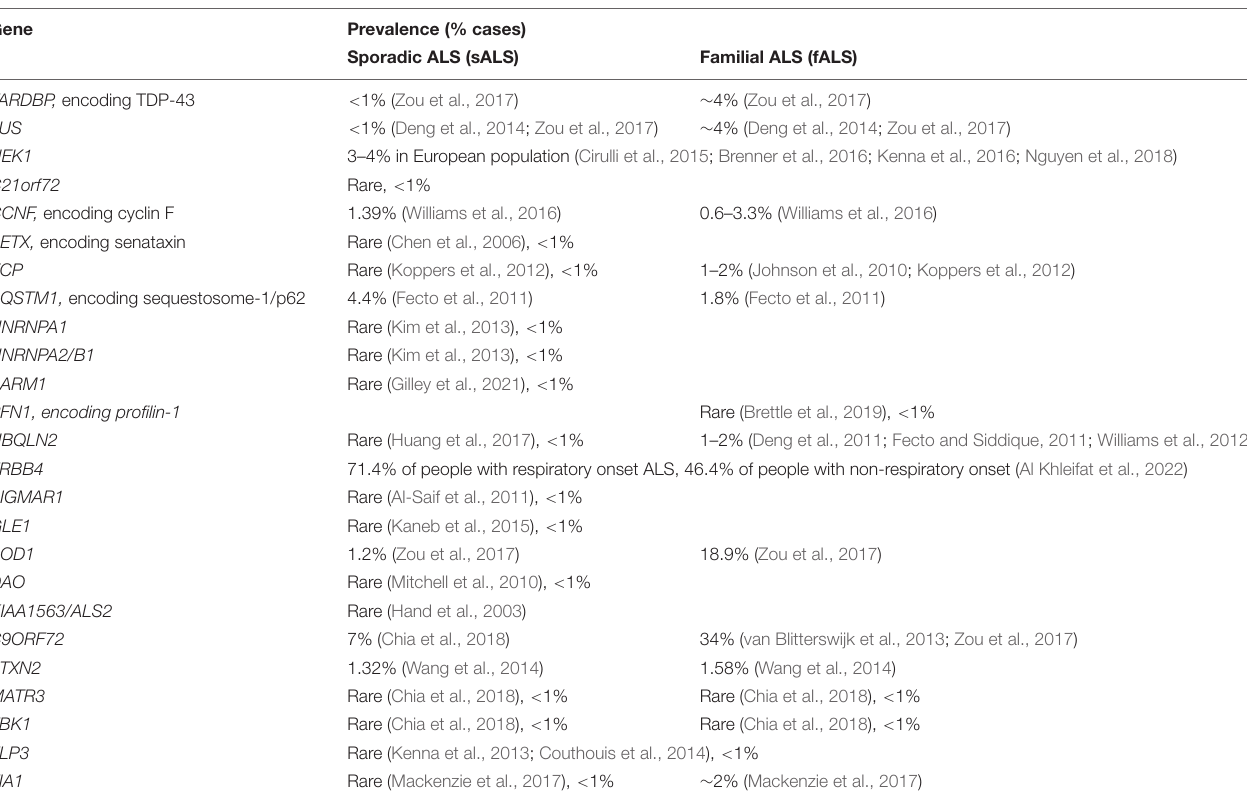
TABLE 1 | Prevalence of mutations present in ALS in genes encoding proteins associated with DNA